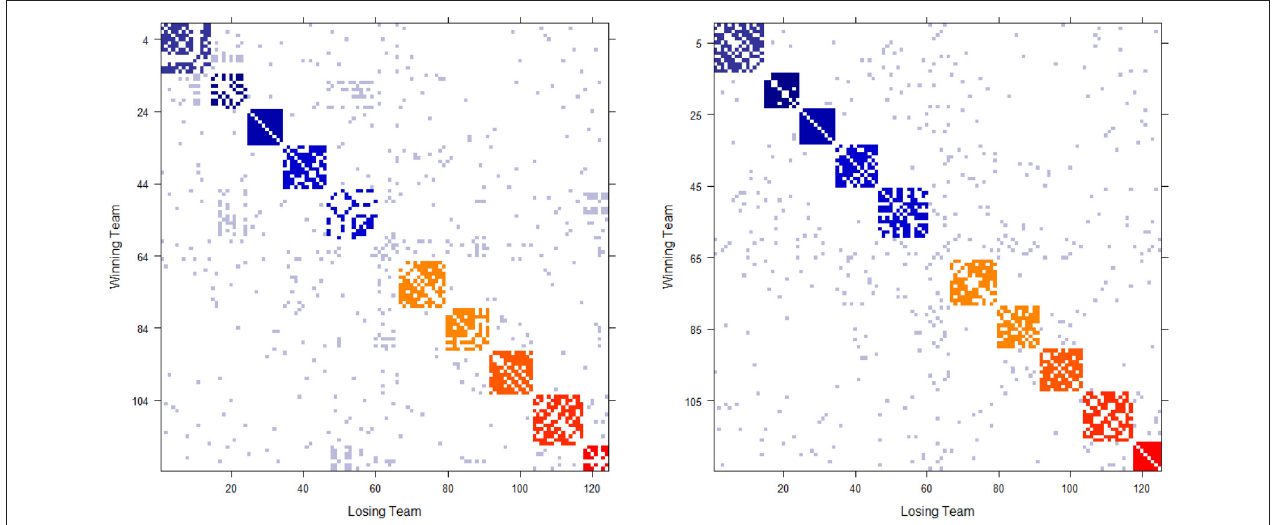
FIGURE 1 | Schedule matrix A 0 of NCAA football data for the 2012 season (Left panel) and 2013 season(Right panel). The schedule matrix is composed of colored diagonal blocks marking the intra-conference games for the real conferences, and off-diagonal inter-conference games are marked in gray. The six independent teams account for the gap in the middle rows and columns. Conferences, from blue to red, are ACC, American, Big 12, Big Ten, Conference-USA, Independent schools, Mid-American, Mountain West, Pac 12, SEC, and Sun Belt.